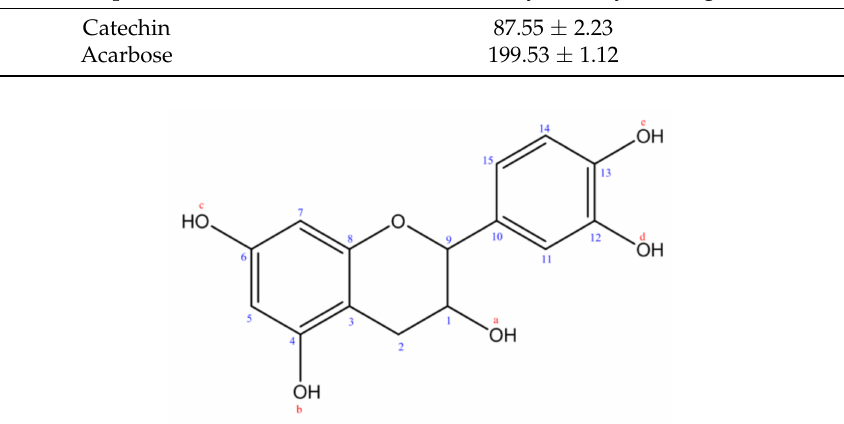
Figure 2. Catechin chemical structure isolated from A. unedo roots using XAD-16